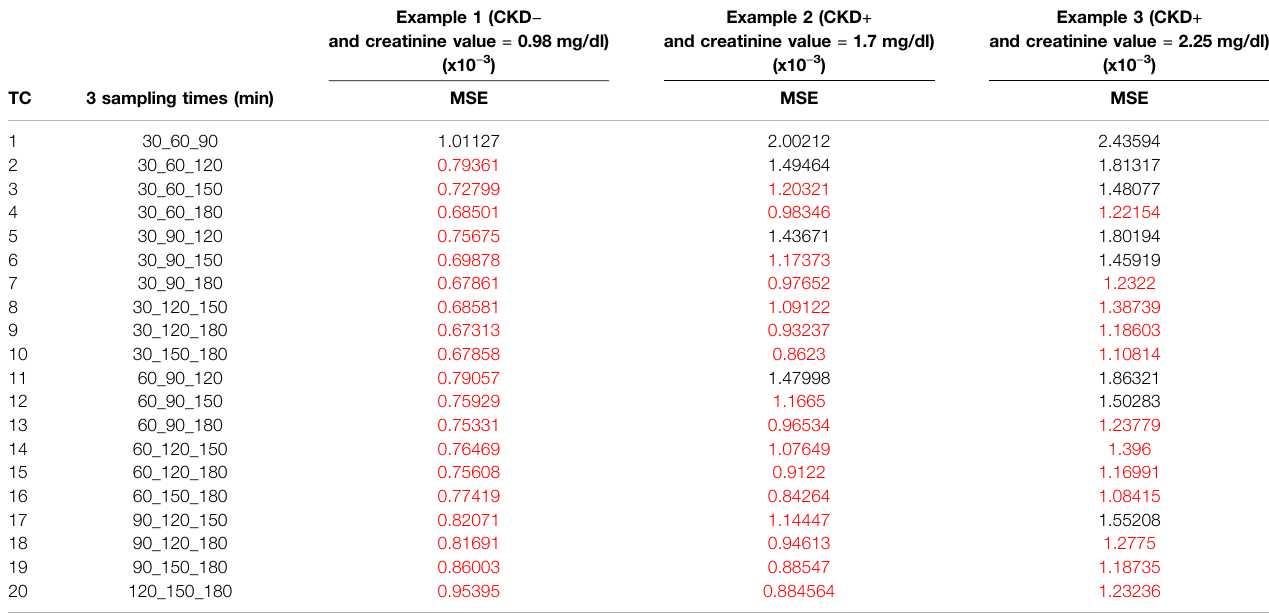
TABLE 5 | Mean square error for the time combination K (MSE K ) results of optimal designs including 3 samples (TC: times combination). The best sampling times for each example of dogs are in red. Example 1 (CKD − and creatinine value = 0.98